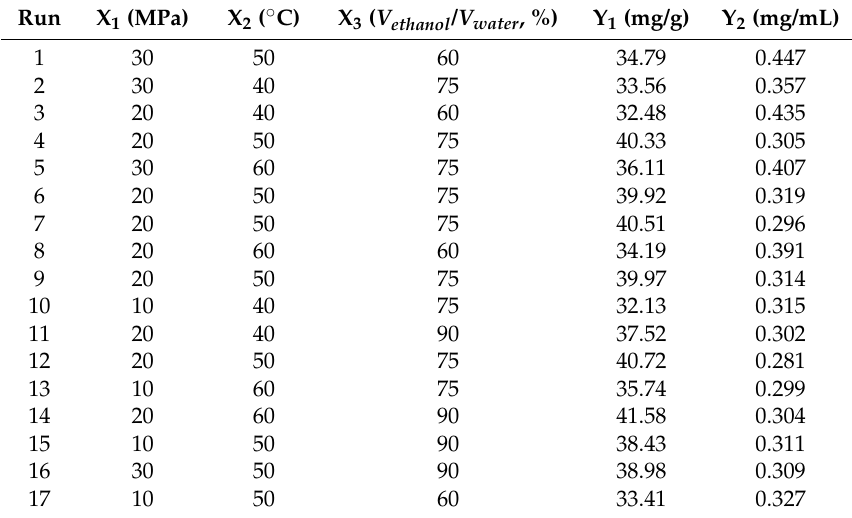
The Box-Behnken experimental design and experimental variables (X 1 : pressure; X 2 : temperature; X 3 : ethanol content) and responses (Y 1 : major flavonol content; Y 2 : IC 50